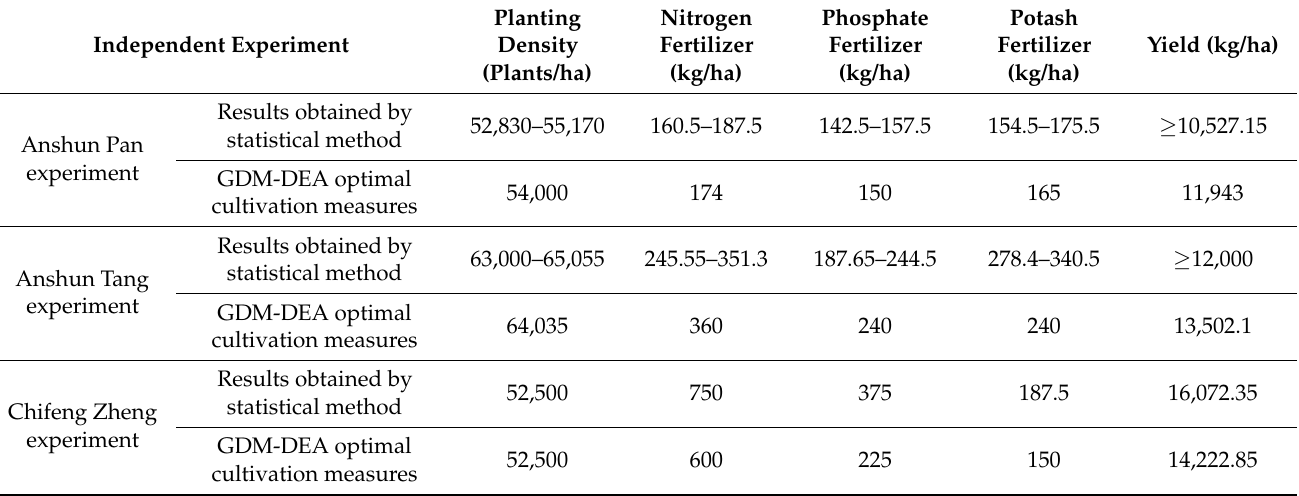
Table 4. Comparison of two kinds of results from the statistical method and GDM-DEA